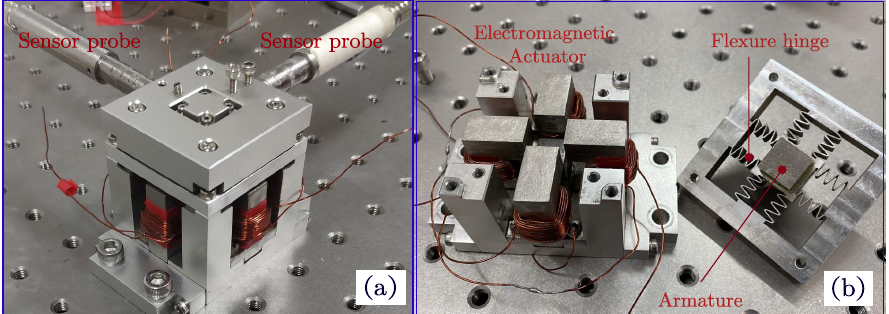
Figure 10. Photograph of the magnetic stage: ( a ) the assembled stage and ( b ) the key components.